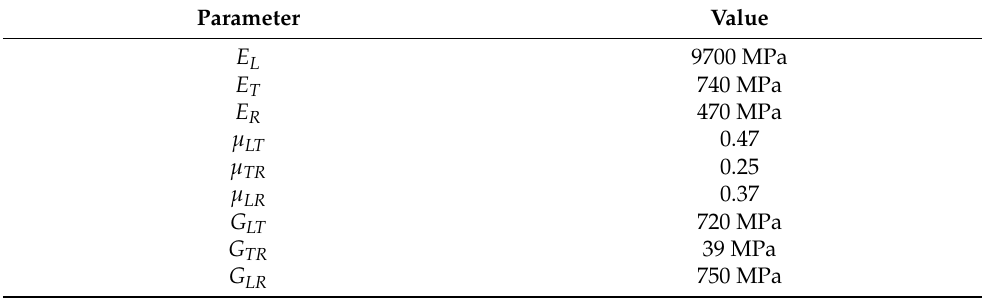
Table 1. Elastic constants for material orthotropy in ANSYS Mechanical